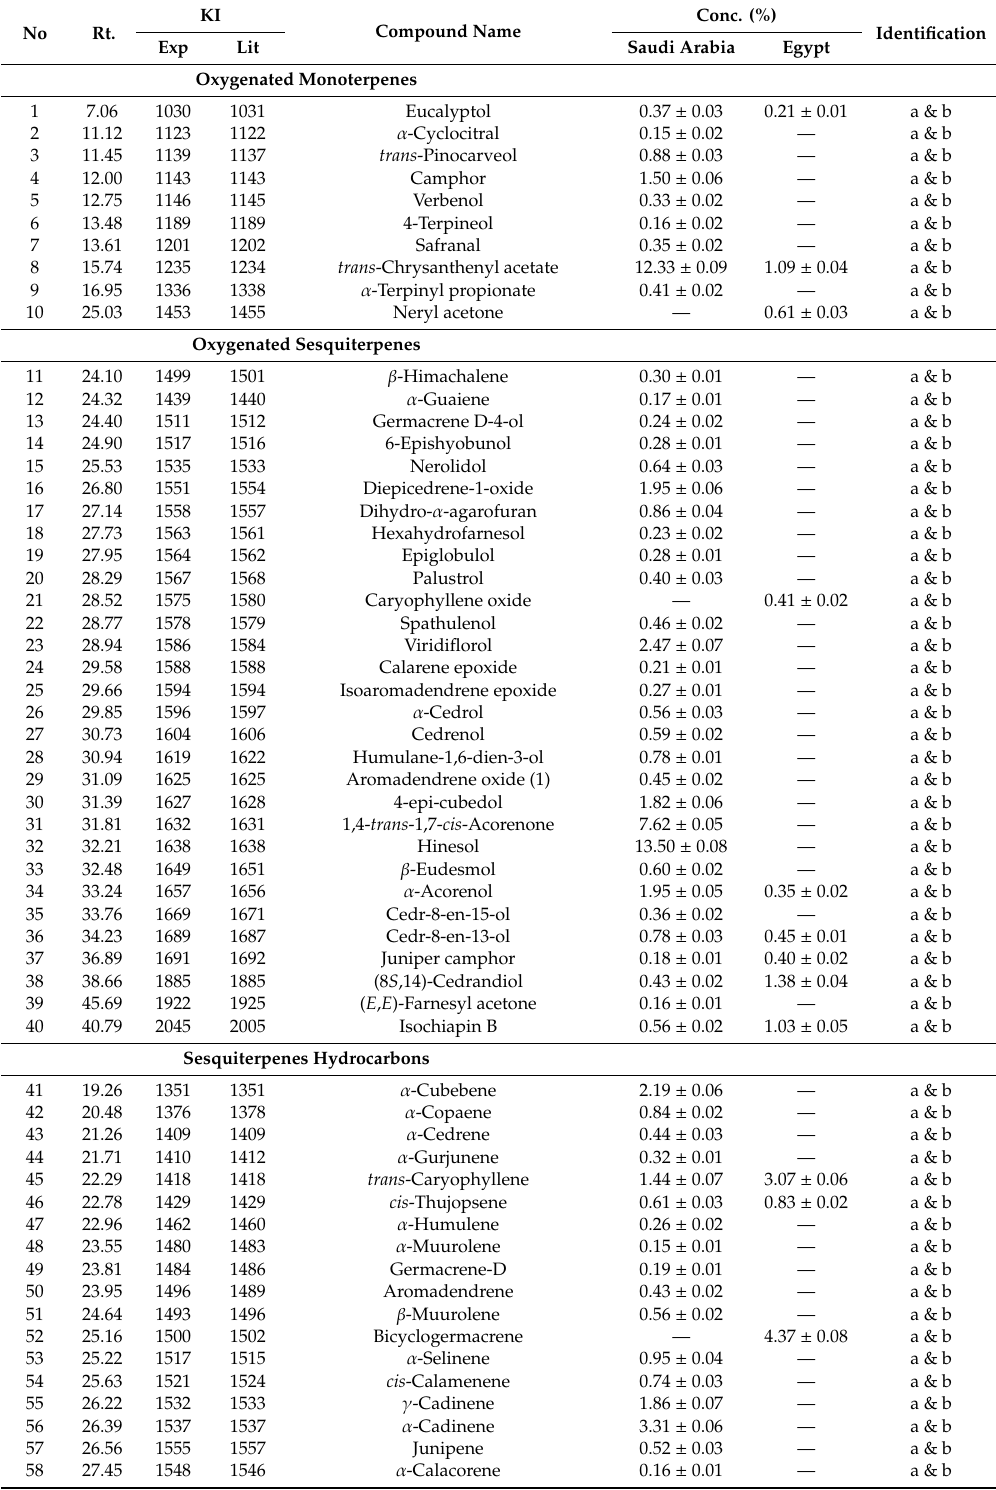
Table 1. Chemical constituents of essential oils (EOs) of the aboveground parts of Calotropis procera collected from Saudi Arabia and